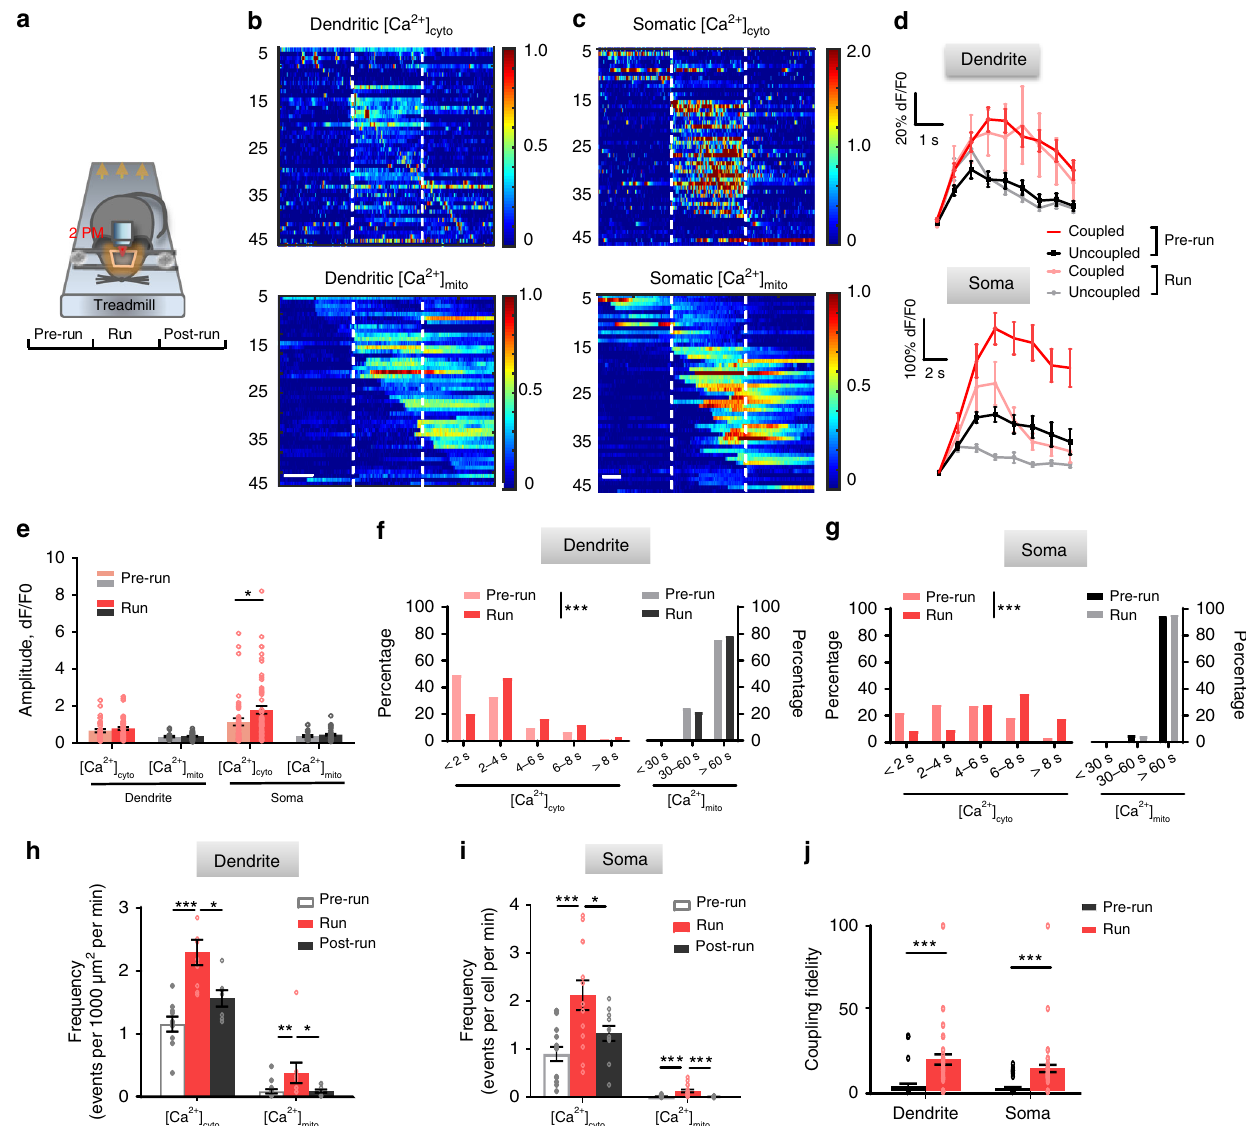
Fig. 4 Enhanced [Ca 2 + ] mito -to-[Ca 2 + ] cyto coupling amidst exercise-elicited neuronal activity. a Schematic of transcranial two-photon imaging in the forelimb motor cortex of awake, head-restrained mice before, during and after running on treadmill. b , c Heatmaps of [Ca 2 + ] cyto and [Ca 2 + ] mito activity in dendrites and somas under different conditions. Vertical dashed lines partition records obtained in the pre-run, run, and post-run stages. Each row represents Ca 2 + activity from a dendrite ( b , n = 48 events) or a soma ( c , n = 49 events). Pairs of [Ca 2 + ] cyto (upper panels) and [Ca 2 + ] mito activities (lower panels) were sorted by time of peak amplitude of [Ca 2 + ] cyto activity. Scale bars: 20 s. d Averaged [Ca 2 + ] cyto transients in dendrites (upper panel) and somas (lower panel) prior to and during treadmill running. 52 – 60 traces were used for each group. e Amplitudes of [Ca 2 + ] cyto and [Ca 2 + ] mito transients in dendrites ( n = 18 – 55 dendrites from 6 mice) and somas ( n = 21 – 60 somas from 7 mice) during pre-run and run stages. f , g Histogram of duration of [Ca 2 + ] cyto and [Ca 2 + ] mito transients in dendrites ( f ) and somas ( g ) during pre-run and run stages. ( f : n = 66 dendrites from 6 mice; g : n = 67 somas